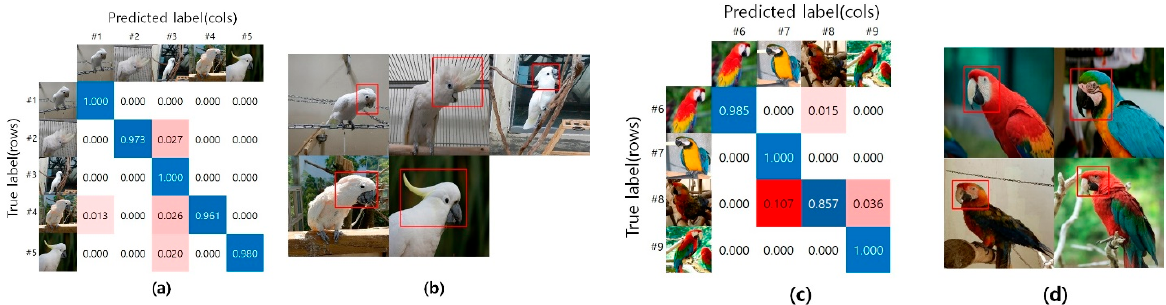
Figure 6. The sample data used for deep neural network from #1 to #9. ( a ) DenseNet18 model confusion matrix corresponding to #1 to #5; ( b ) Cacatua genus; ( c ) DenseNet18 model confusion matrix corresponding to #6 to #9; ( d ) Ara genus.